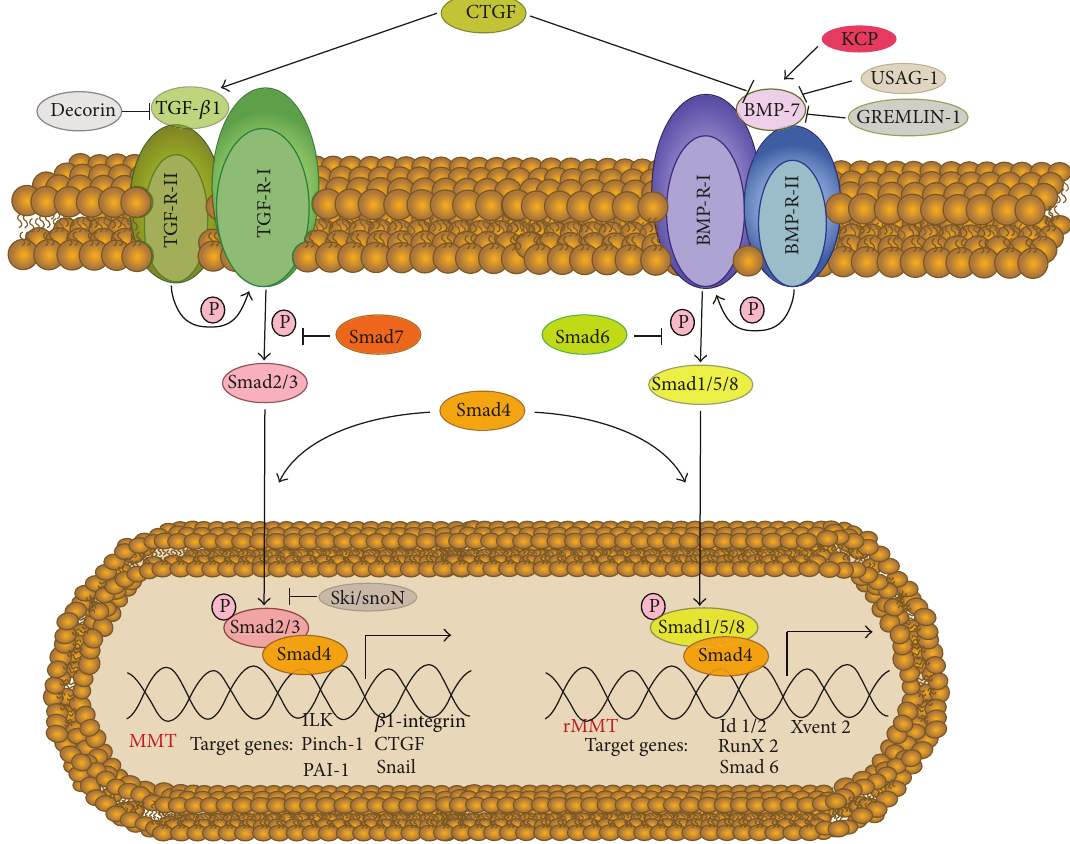
Figure4:Smad-dependentsignalingpathwaysofTGF- 𝛽 1andBMP-7.ThebindingofTGF- 𝛽